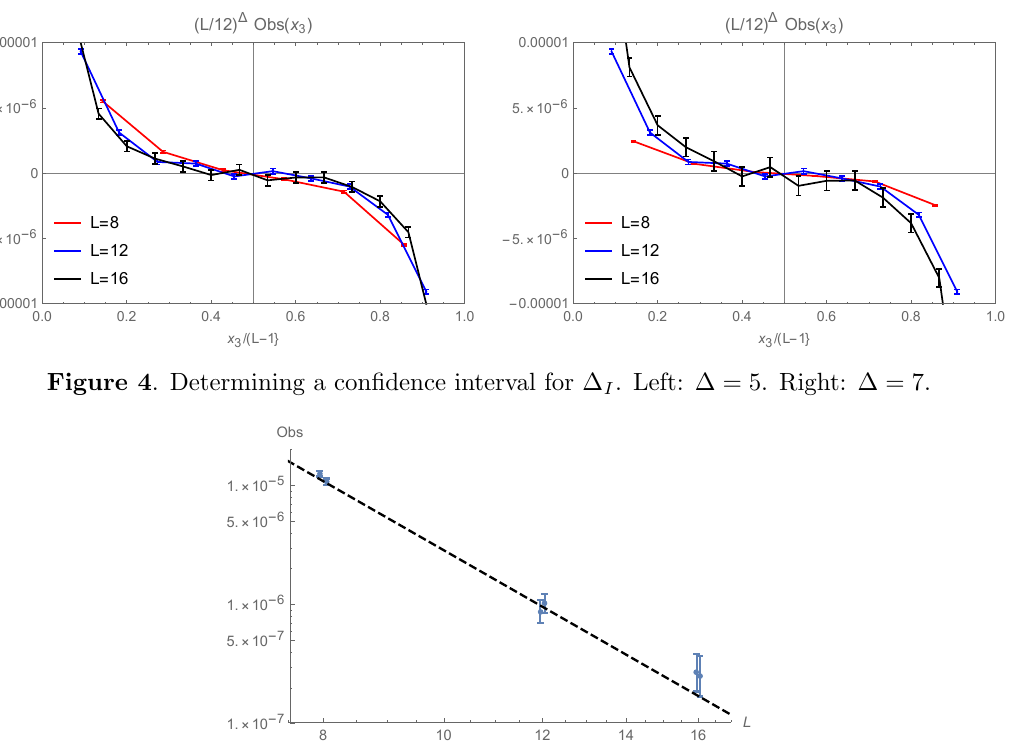
Figure 5 . Observable for x 3 = 2 ( L = 8), x 3 = 3 ( L = 12) and x 3 = 4 ( L = 16) and for the three mirror points (with a minus sign). The dashed line is the best (cid:12)t c=L (cid:1) which gives (cid:1) = 6 : 03 as the central